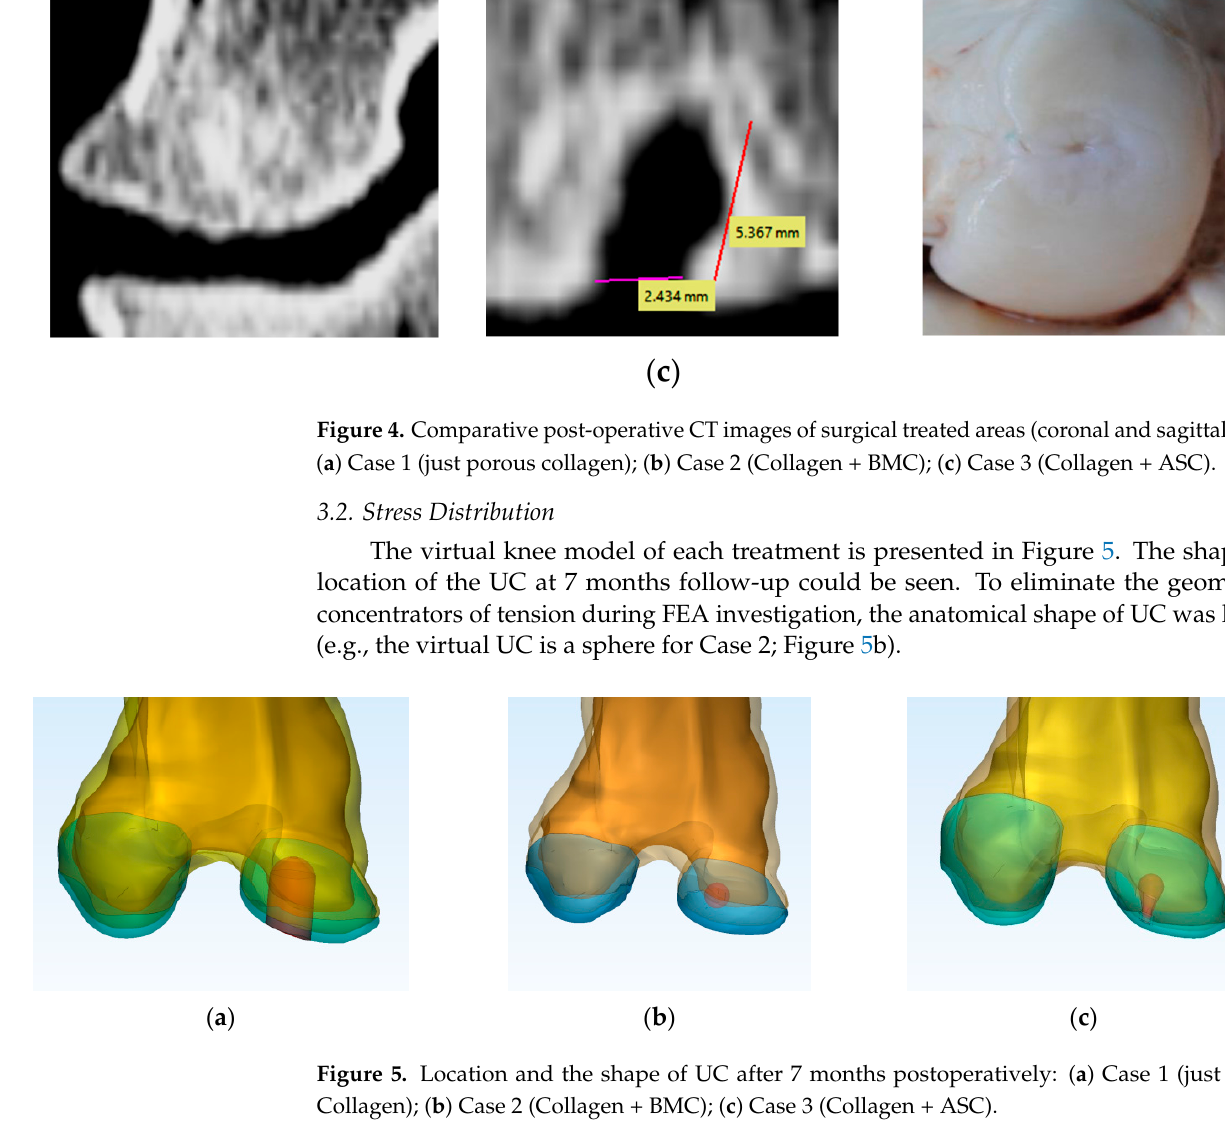
Figure 5. Location and the shape of UC after 7 months postoperatively: ( a ) Case 1 (just porous Collagen); ( b ) Case 2 (Collagen + BMC); ( c ) Case 3 (Collagen + ASC).